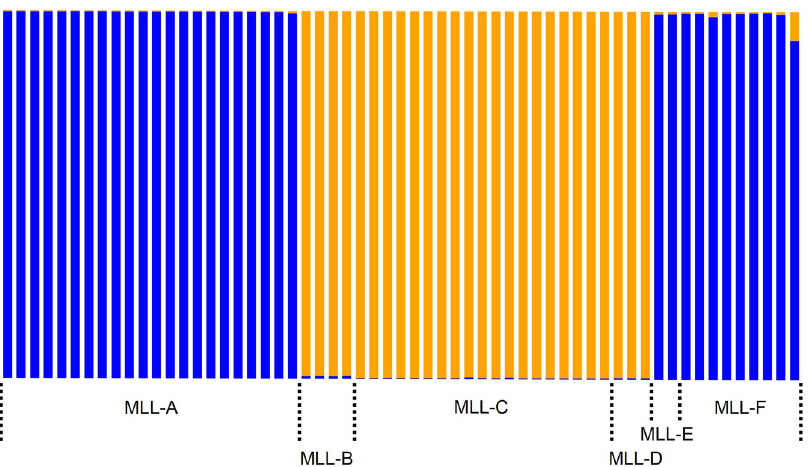
Fig 4. Assignment of each of the 59 MLG to the two clusters inferred by Structure. MLG were defined using nine microsatellite markers.